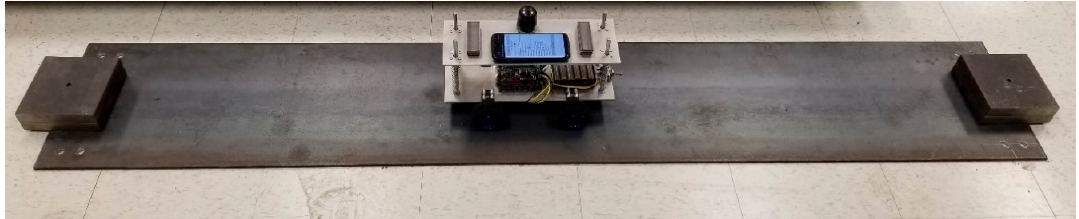
Figure 11. Set-up for simulating the off-bridge condition . Spring A Spring B Spring C